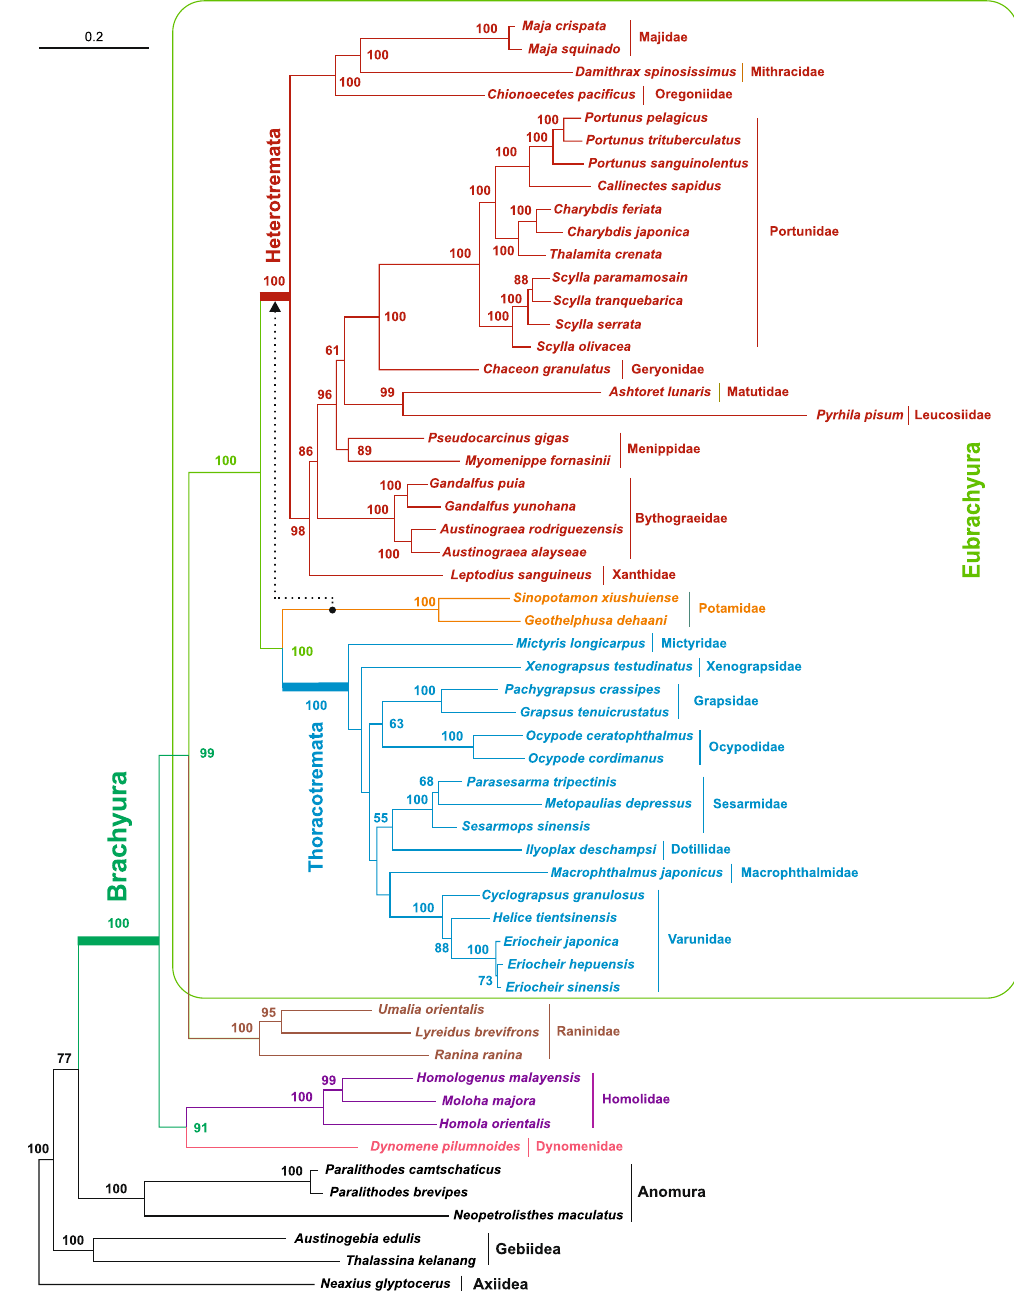
Figure 3. The mitochondrial phylogenomic tree of Brachyura. ML tree (-ln = 112327.8522) obtained from the analysis performed on the 56 T.PRO multiple alignment. Ultrafast bootstrap values ≥ 50% are provided for each node. The alternative phylogenetic placement of Potamidae (see main text) is depicted as a dotted line. The scale bar represents 0.2 substitution/site. Taxa names are coloured as in Fig.